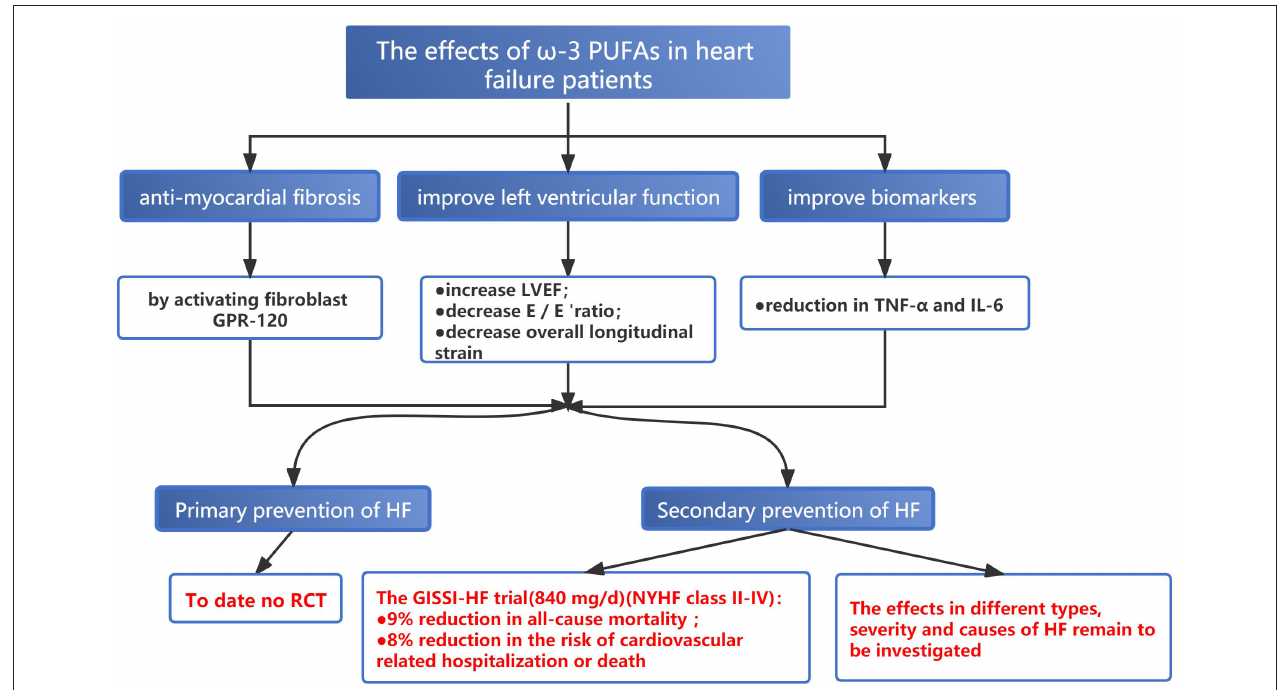
FIGURE 6 | The effects of ω -3 PUFAs in heart